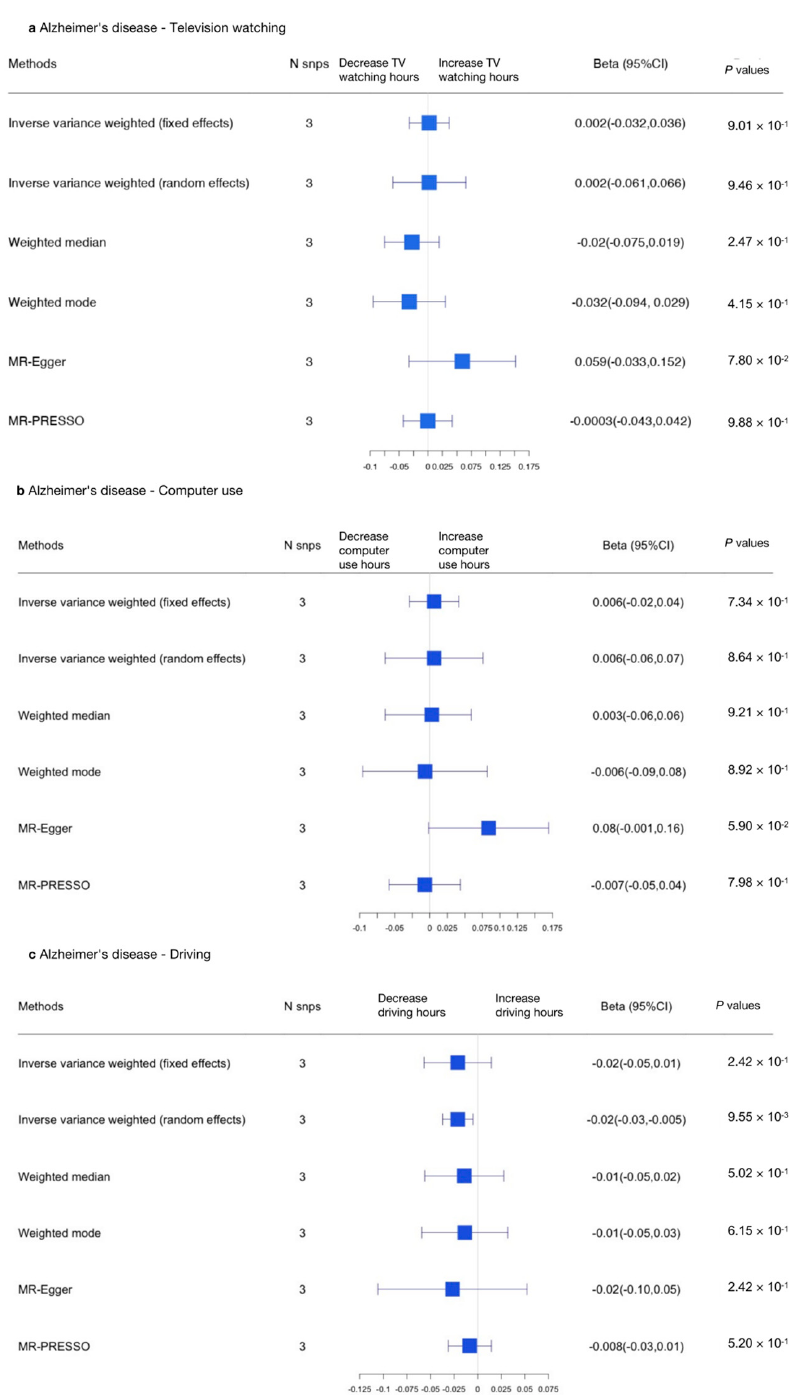
Figure 3. Summarized Mendelian randomization (MR) effect sizes of AD and sedentary behaviors. Summarized MR effect sizes of the causal relationship between AD and ( a ) television